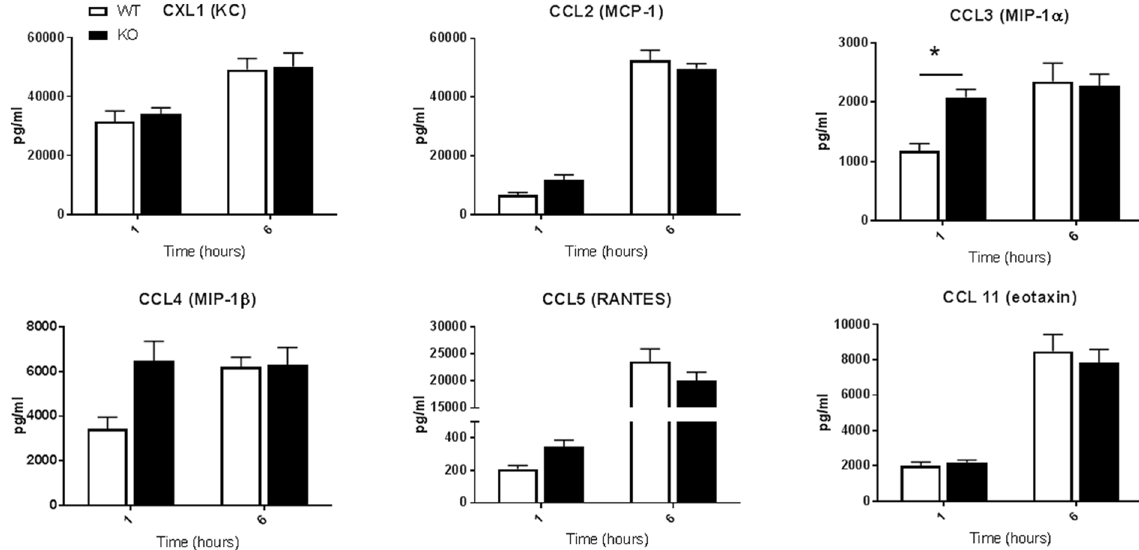
Figure 8. Serum chemokine levels in WT and ficolin KO mice after LPS challenge with a lethal dose. Groups of WT and ficolin KO mice were intraperitoneally injected with LPS of a lethal dose (10 mg/kg). At 1 h or 6 h after challenge, blood was collected before the mouse was sacrificed. The serum concentration of chemokines was measured by a multiplex Luminex assay; the data was obtained from two independent experiments per time point and represent mean ± SEM (n = 11 mice per group per time point). * p < 0.05 for WT to ficolin KO comparisons (unpaired two-tailed Student’s t